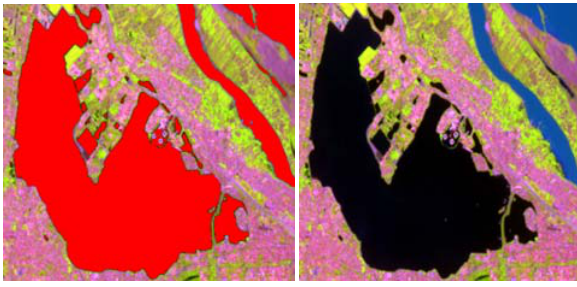
Figure 10. Water body extraction for Spot 5 HRG (top),) and in colour composite (bottom)